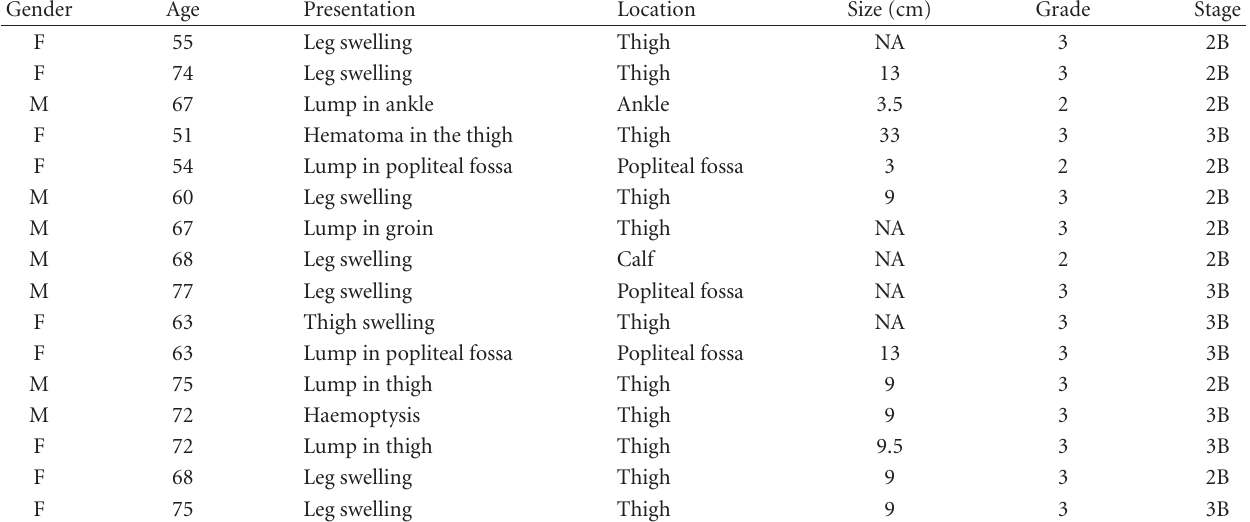
Table 1: The clinical presentation in patients with leiomyosarcoma of vascular origin. NA = Not